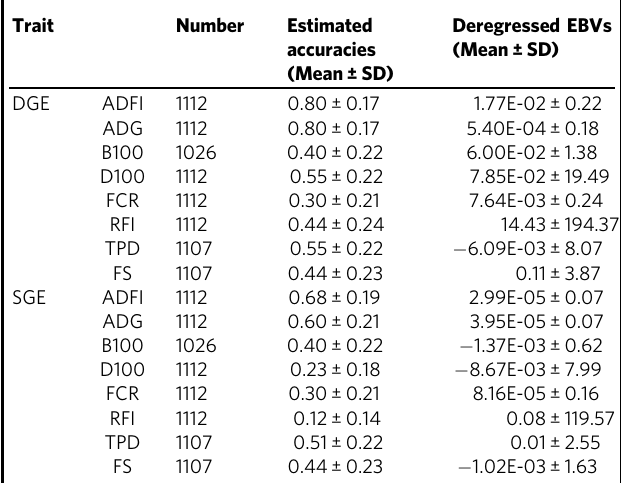
Table 2 Summary of the estimated accuracies and deregressed EBVs for direct genetic (DGE) and effects social genetic effects (SGE) in Yorkshire